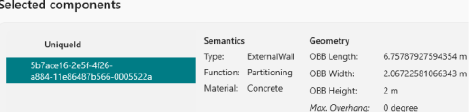
Figure 12. Prototype of the DDSS portal whose functionalities will be continuously extended. ( a ) Building component’s geometry and semantics received from the BIM toolkit. ( b ) AMC methods and evaluation results.